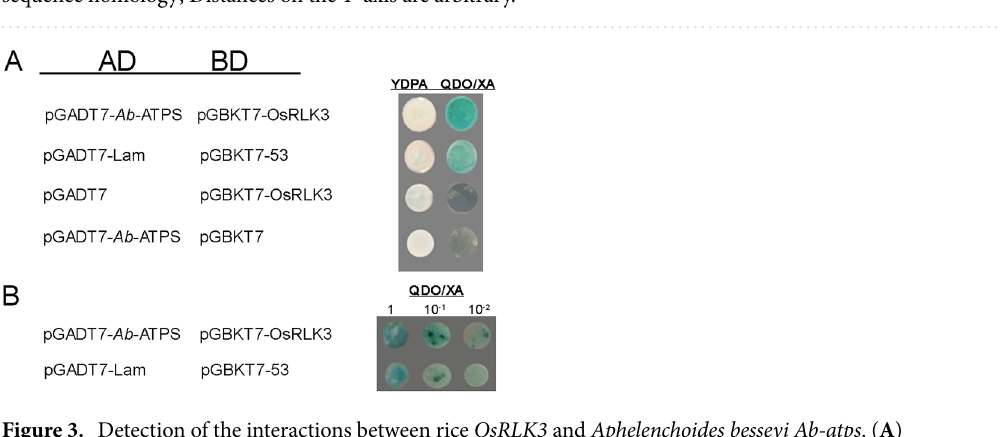
Figure 2. Phylogram constructed on the basis of amino acid sequences depicting the evolutionary relationships among ATP synthase (ATPase) from 24 species of nematodes. Aphelenchoides besseyi Ab -ATPS is underlined; Accession numbers of the sequences are shown in brackets; Distances on the X -axis correspond to the grade of sequence homology; Distances on the Y -axis are arbitrary.